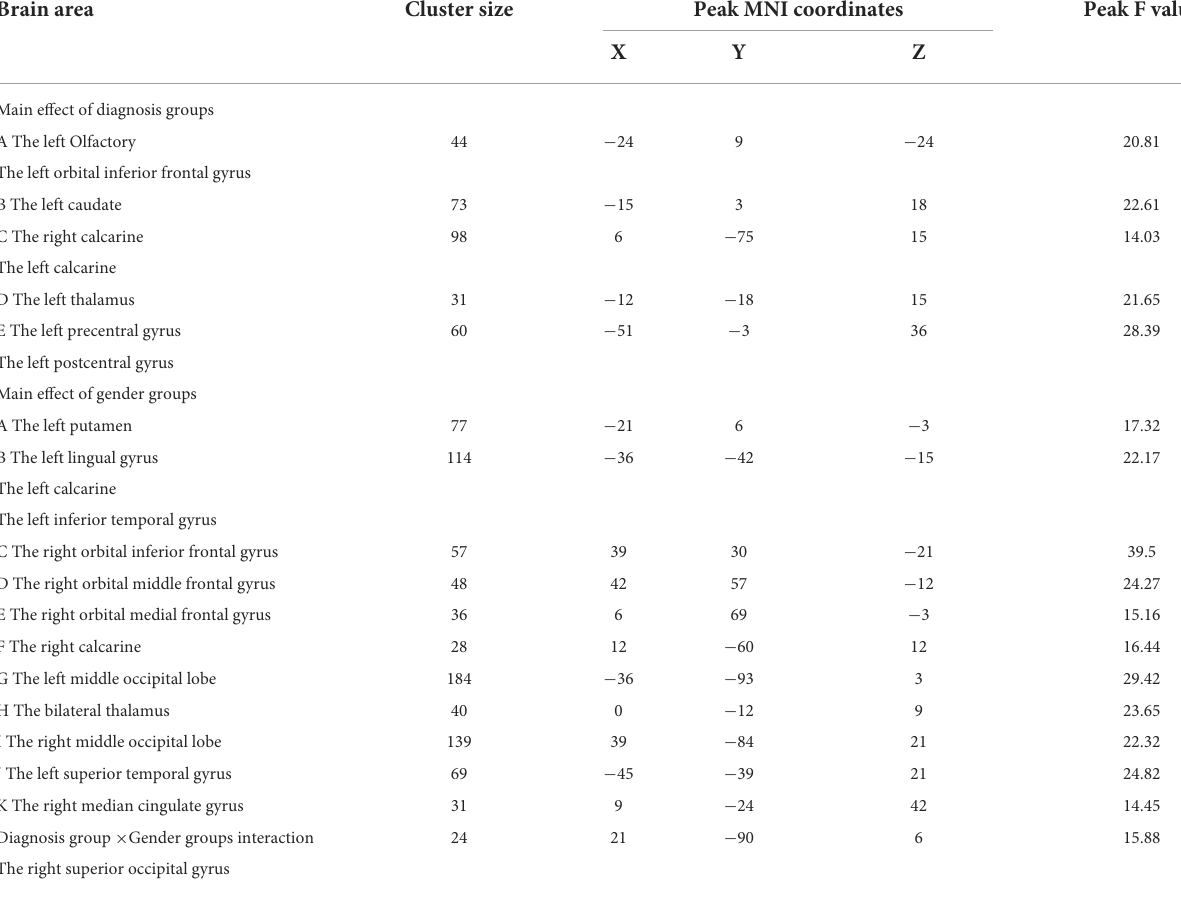
TABLE 3 Clusters exhibiting the influence of male and female sex on ALFF in the MDD and HC groups. Brain